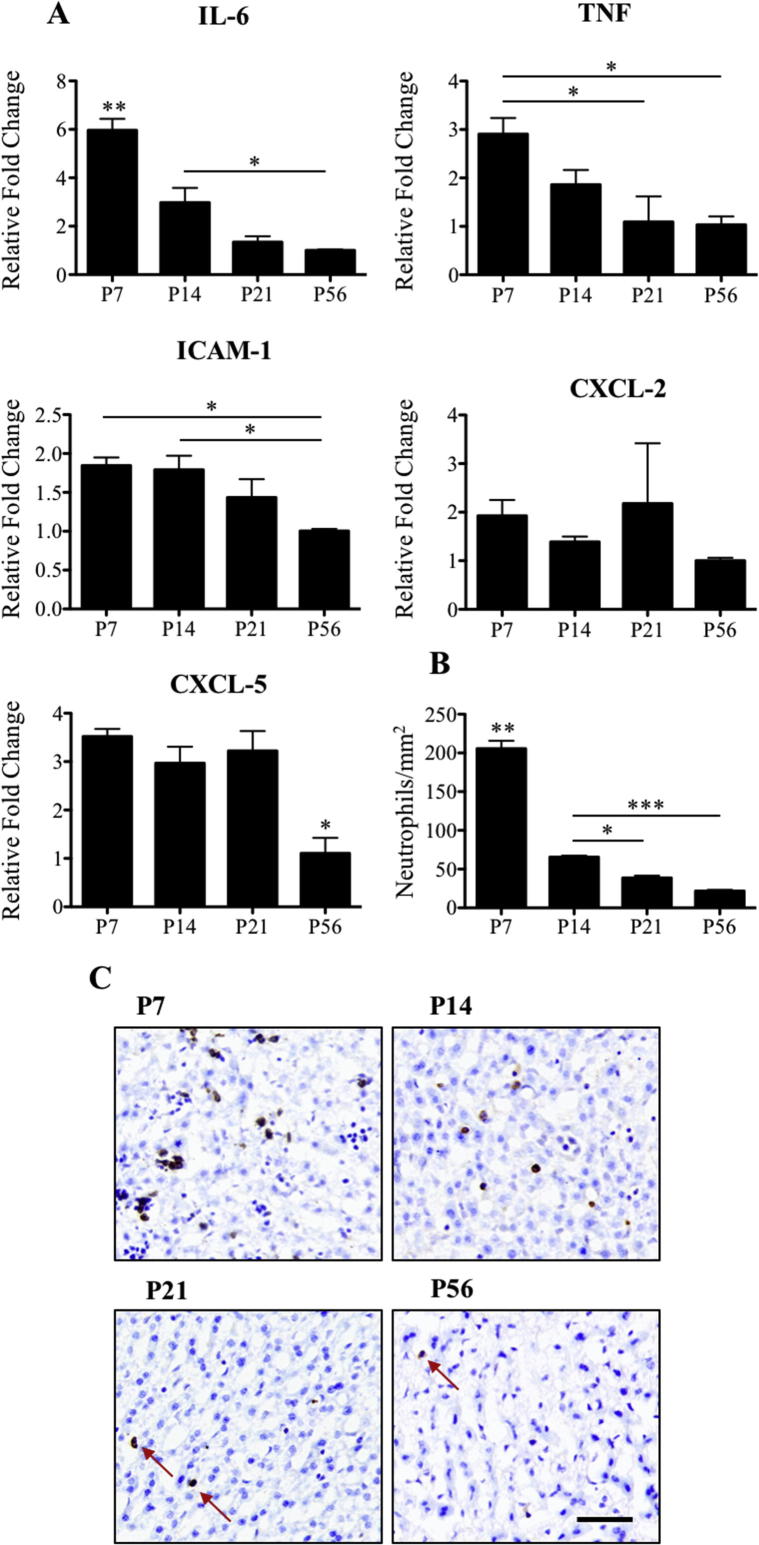
mRNA expression of inflammatory mediators and neutrophil population in the liver during postnatal development. (A) IL-6, TNF, ICAM-1, CXCL-2 and CXCL-5 mRNA expression in the liver of naïve mice at different postnatal ages (P7, P14, P21 and P56). Data are represented as relative fold change from expression levels of P56 mice. For most genes, the highest expression was measured at P7 and was reduced during further postnatal development. No change in CXCL-2 was found in the liver over the developmental period studied, while the expression of CXCL-5 remained high until P21 and was significantly reduced at P56. The number of neutrophils per mm2 of liver also decreased during postnatal development (B, C). Scale bar = 50 µm. ∗p < 0.05, ∗∗p < 0.01 and ∗∗∗p < 0.001. P7: n = 4, P14: n = 4, P21 n = 4 and P56: n = 3.